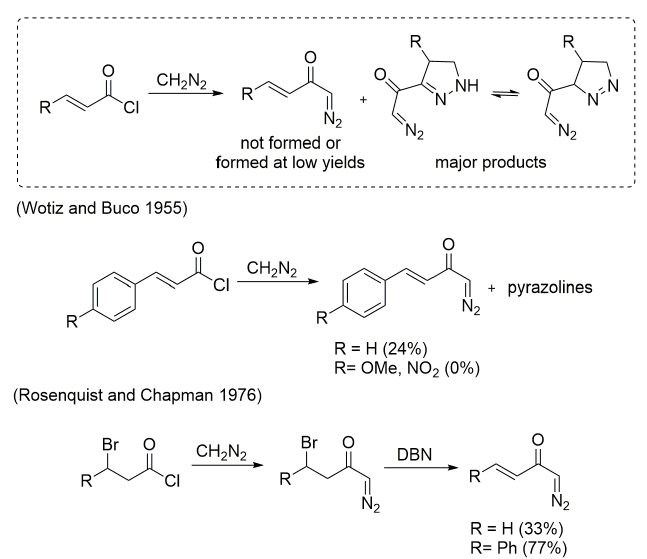
Figure 6 - Some synthetics intermediates obtained by acylation of higher